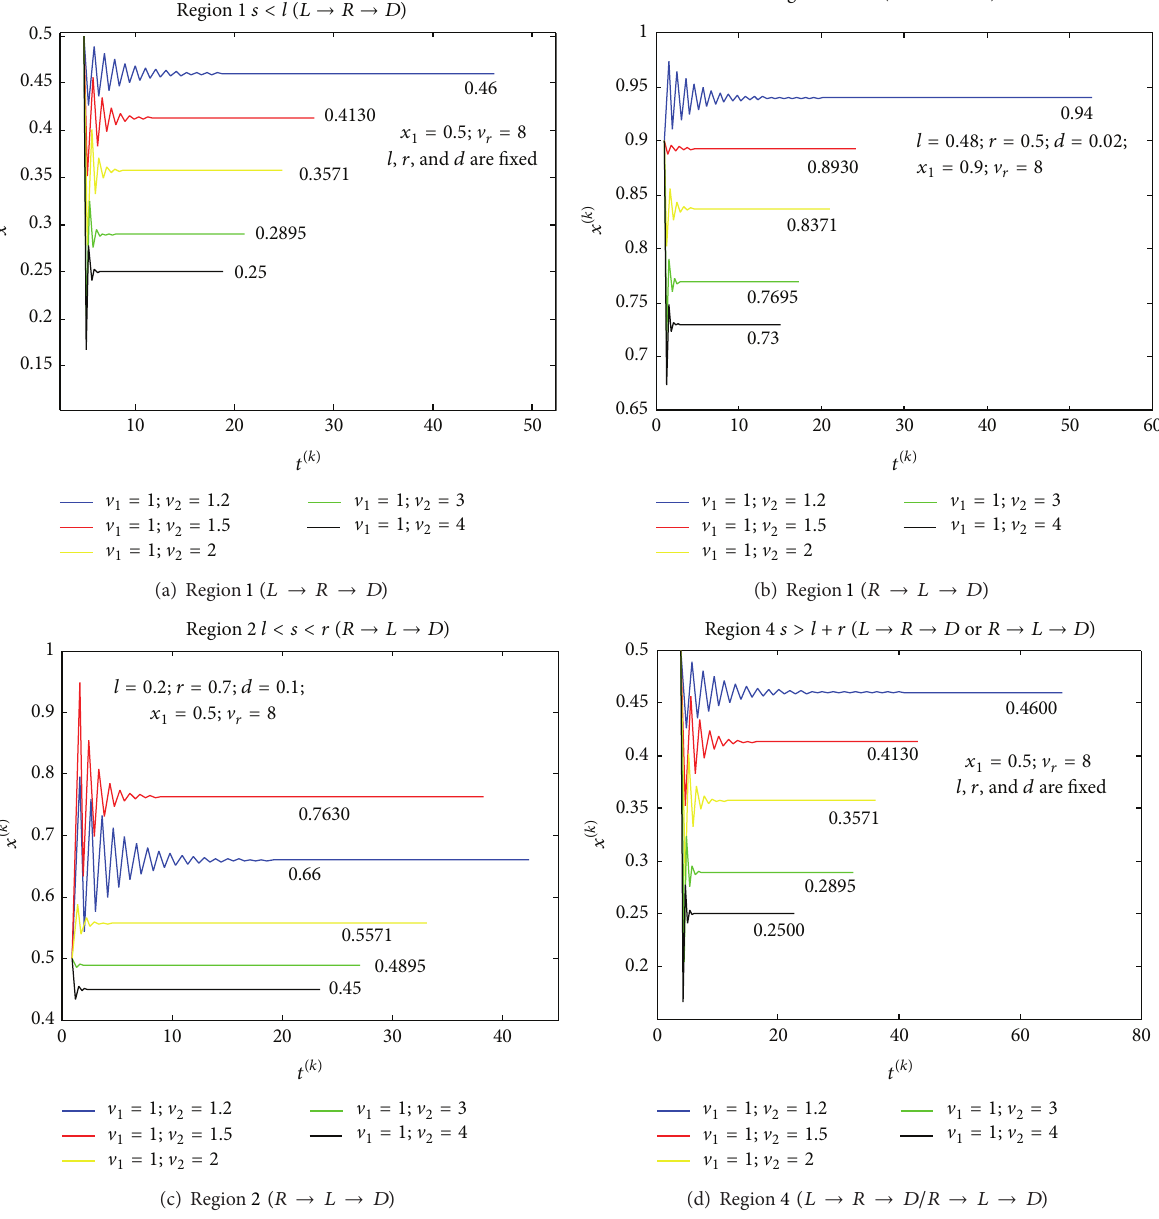
Figure 8: Effect of working velocity difference on system’s stable